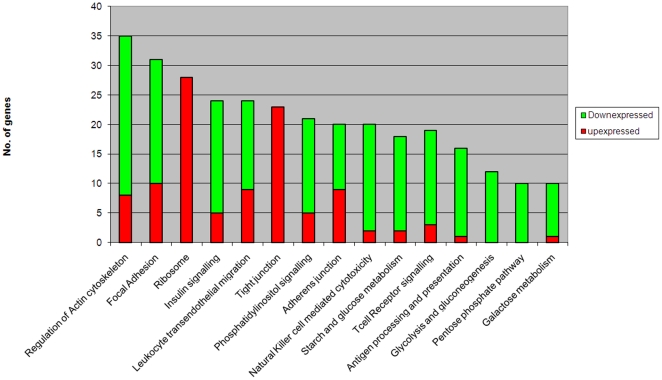
Proportion of differentially expressed genes in significantly affected pathways.